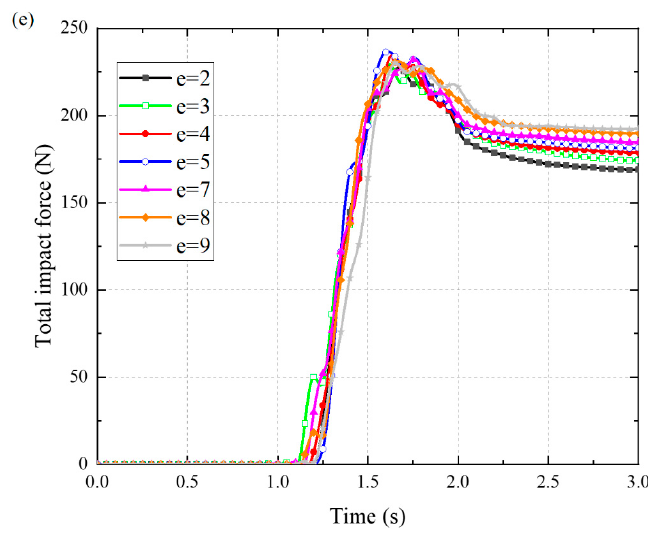
Figure A1. Sensitivity analysis showing the e ff ect of input parameter variation, including ( a ) µ s , ( b ) µ 0 f , Figure A1 Sensitivity analysis showing the effect of input parameter variation, including ( a ) 𝜇 (cid:3046) , ( b ) ( c ) µ rs , ( d ) µ r 0 and ( e ) e, on impact force computed by the proposed DEM 𝜇 (cid:2868)(cid:3033) , ( c ) 𝜇 (cid:3045)(cid:3046) , ( d ) 𝜇 (cid:3045)(cid:2868) and ( e ) e, on impact force computed by the proposed DEM model.